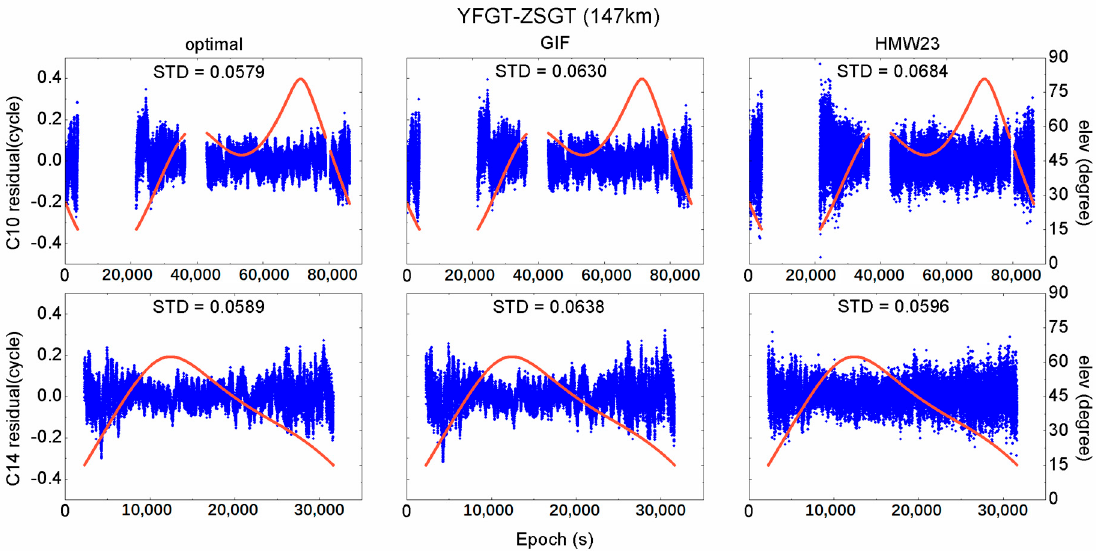
Figure 4. Comparison of ambiguity residuals and the corresponding standard deviations of optimal , GIF , and HMW23 combinations for the long baseline (147 km).